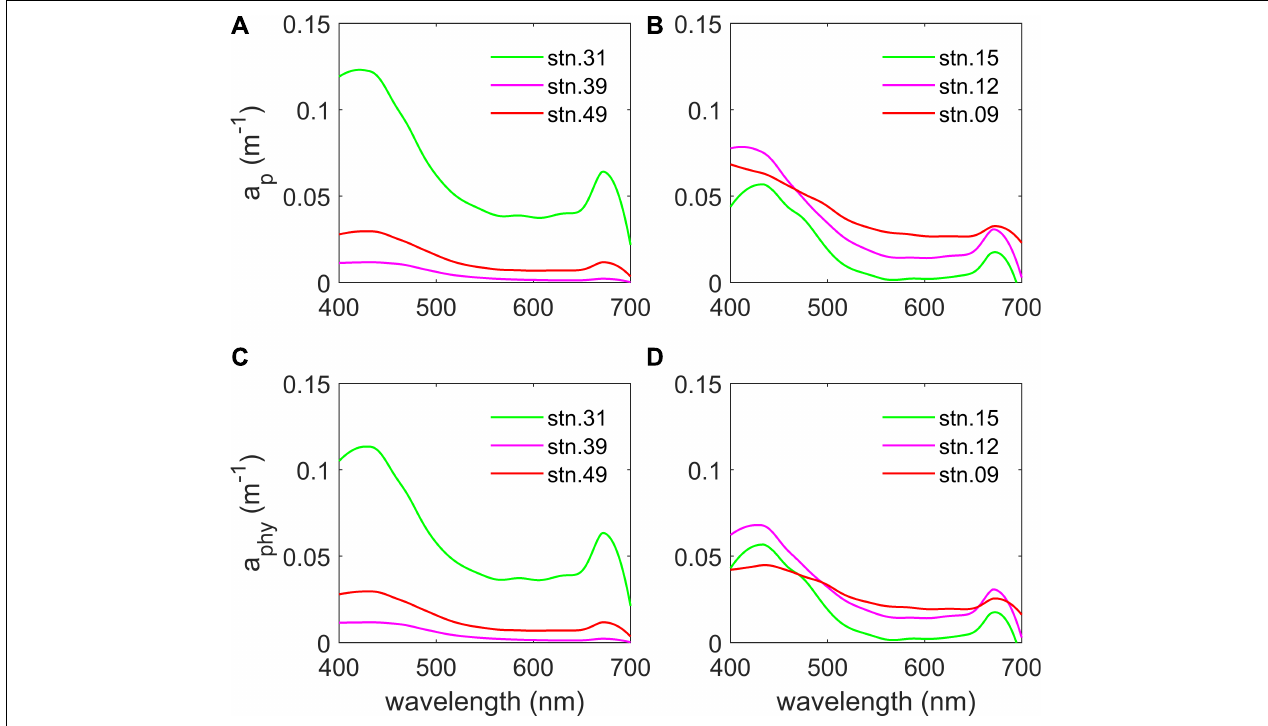
FIGURE 6 | Spectral absorption properties of particulate (A,B) and phytoplankton pigments (C,D) at stations representing the three different water masses in Vaigat-Disko Bay (left panel) and sections in the Godthabsfjord (right panel).